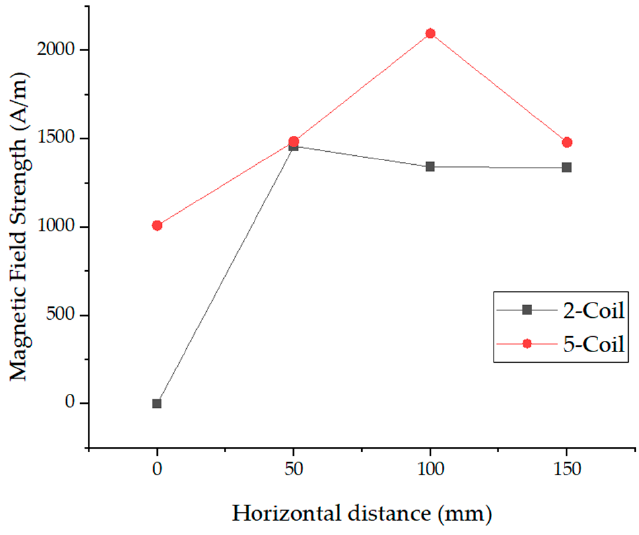
Figure 20. Strength (RMS) of magnetic fi eld according to coil axis separation distance.